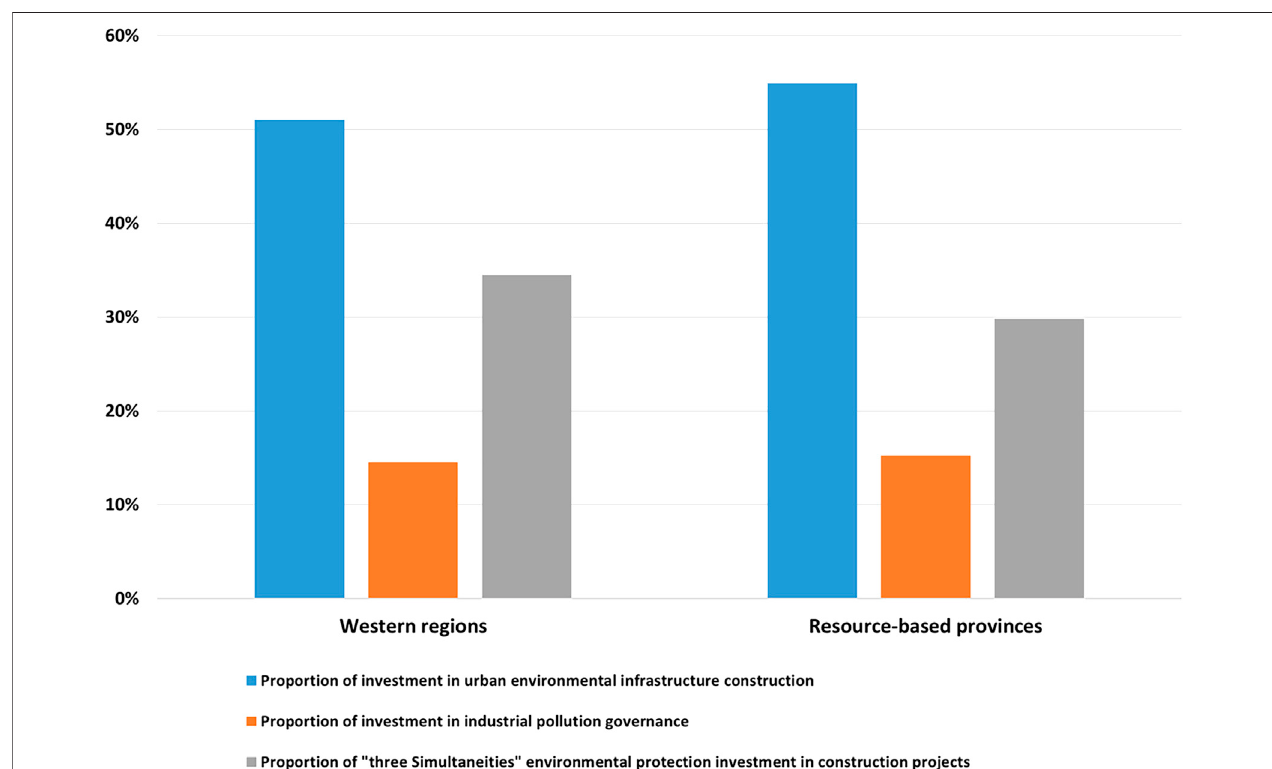
FIGURE 1 | Proportion of three types of EGI in